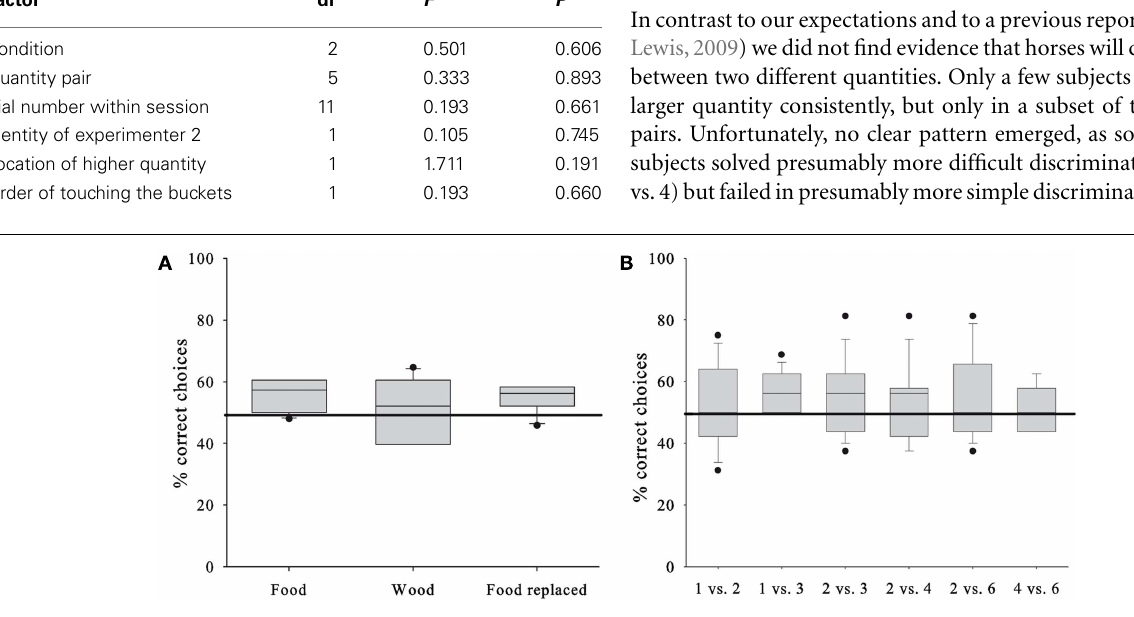
FIGURE 2 | Horses’ test performances. (A) Percentage of correct choices in each of the conditions. (B) Percentage of correct choices in each of the six quantity pair discriminations. Box plots show median and 25th and 75th, percentiles, whiskers show 10th- and 90th percentiles and dots represent outliers. Horizontal line represents chance